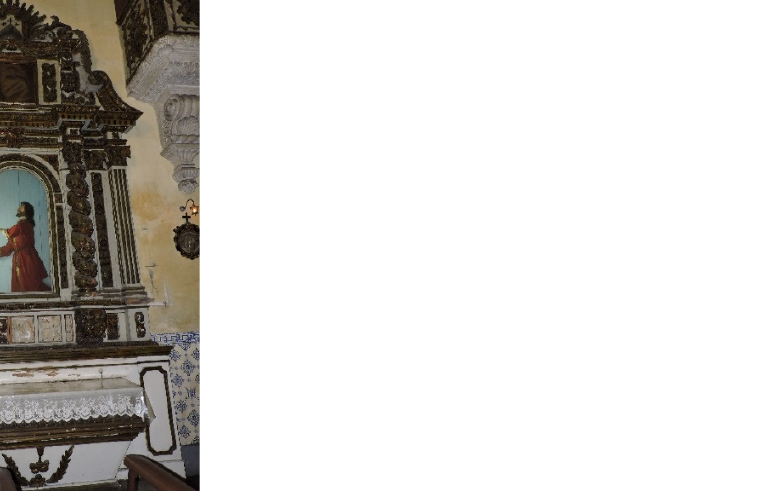
Figure 12. Altarpiece of the Agony in the Garden. Photo by Lia Brusadin, 29 December 2016.